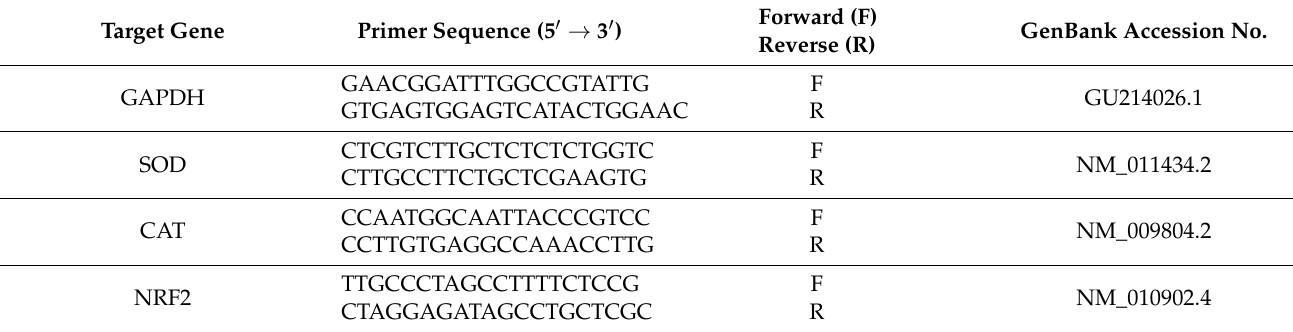
Table 1. The primers pairs used for real-time